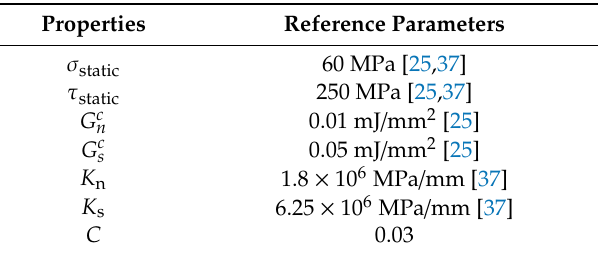
Table 3. Constants of rate-dependent cohesive zone model